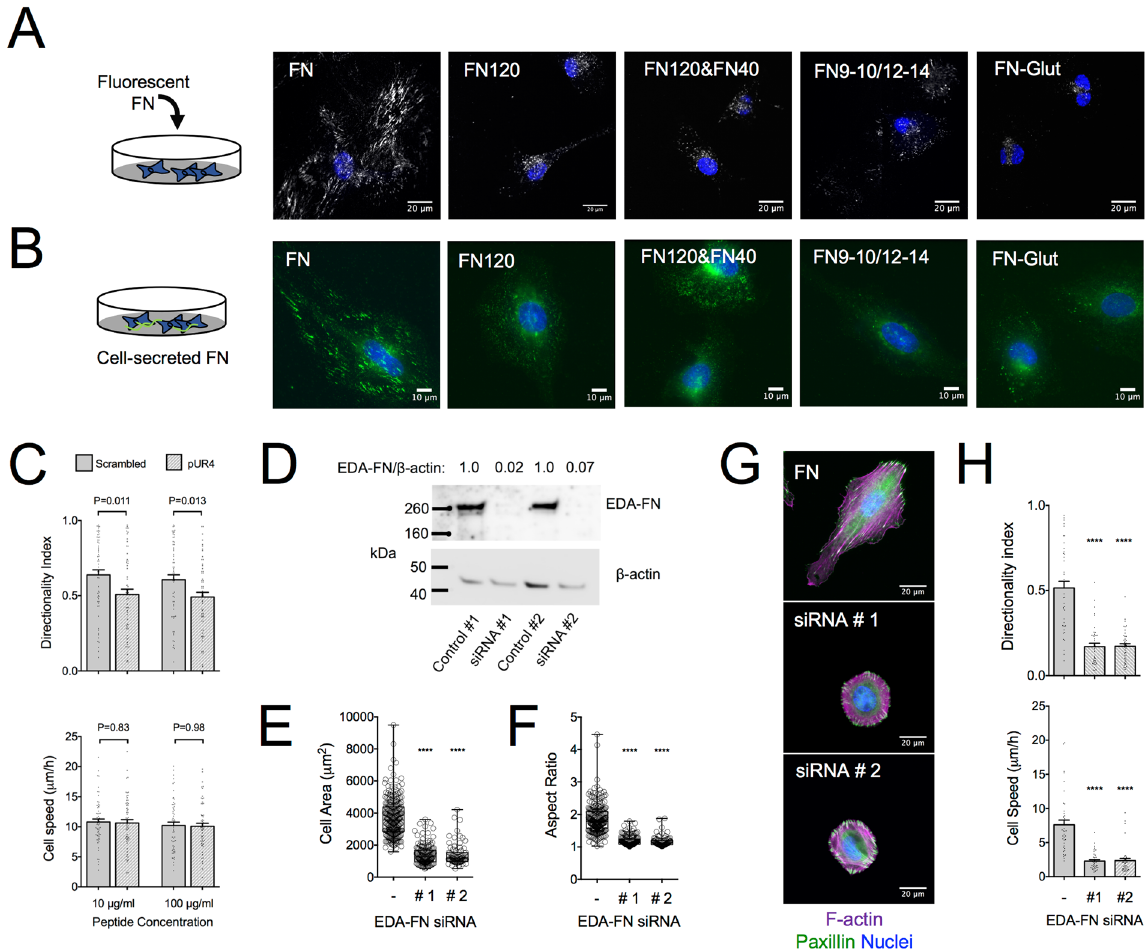
Figure 7. FN fibrillogenesis inhibition impairs directional persistence in fibroblast migration and cellular FN knockdown abolishes migration altogether. ( A ) Confocal microscopy images of fluorescently-labeled FN (gray) bound and/or assembled by REF on substrates with indicated coatings. Culture medium was exchanged 4 hours after seeding with medium containing 10 μ g/ml FFN and incubated for another 20 hours, prior to washing and cell fixation. Fibrillogenesis of soluble FFN was observed only on FN-coated substrates. Nuclei are stained with DAPI (blue). ( B ) Epifluorescence microscopy images of REF immunostained against cellular FN (green), fixed 24 hours after seeding on substrates with indicated coatings. FN fibrillogenesis was evident only on FN-coated substrates. Nuclei are stained with DAPI (blue). Coating concentrations of FN: 10 μ g/ml, FN120: 10 μ g/ml, FN120/FN40: 10/1 μ g/ml and FN9–10/12–14: 10 μ g/ml. ( C ) REF directionality index on FN-coated substrates was reduced in presence of pUR4 peptide compared to a scrambled control peptide, whereas cell speed was unaffected. Values were compared using a Mann-Whitney test (N exp = 3; n = 60). Mean ± s.e.m. are presented. ( D ) Western blot analysis of lysates from REF treated 48 hours with siRNA against EDA-FN. The EDA-FN/ β - actin ratio was obtained by densitometric analysis. ( E ) REF projected cell area and ( F ) aspect ratio 6 hours post-seeding on substrates coated with FN. EDA-FN knockdown resulted in a large reduction of cell area and cell rounding (N exp = 2). Values of siRNA-treated REF were compared to the control condition using one-way ANOVA analysis ( **** P < 0.0001). ( G ) Epifluorescence microscopy images of control or siRNA-treated REF seeded for 6 hours on FN-coated substrates, fixed and stained against paxillin (green), F-actin (magenta) and DNA (blue). EDA-FN knockdown changed dramatically cell morphology but did not impair focal adhesion or stress fiber formation. ( H ) REF speed and directionality index calculated for control and siRNA-treated REF on FN. EDA-FN knockdown abolished migration, with residual cell speed reflecting nuclei movements within the cell body. Data were compared using one way ANOVA analysis ( **** P < 0.0001). Mean ± s.e.m. are presented (N exp = 2; n =